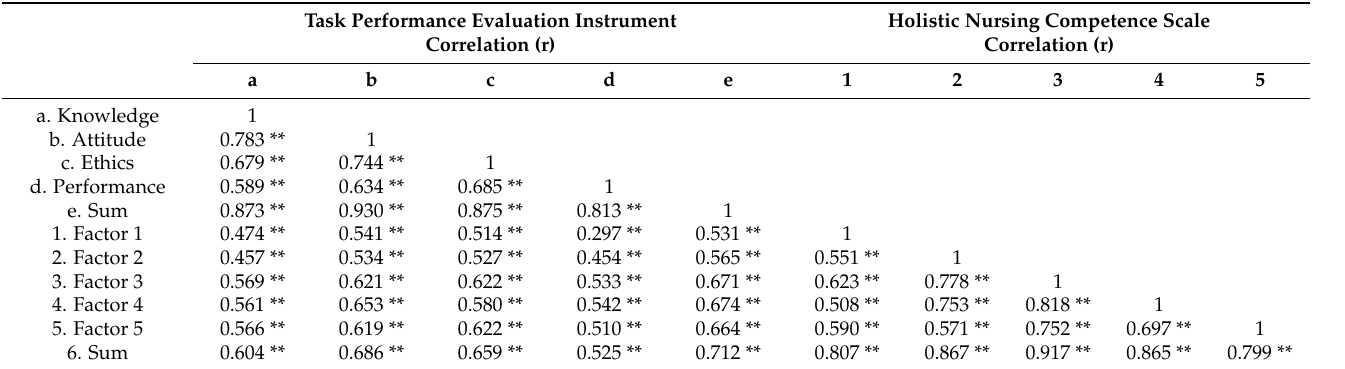
Table 6. Concurrent